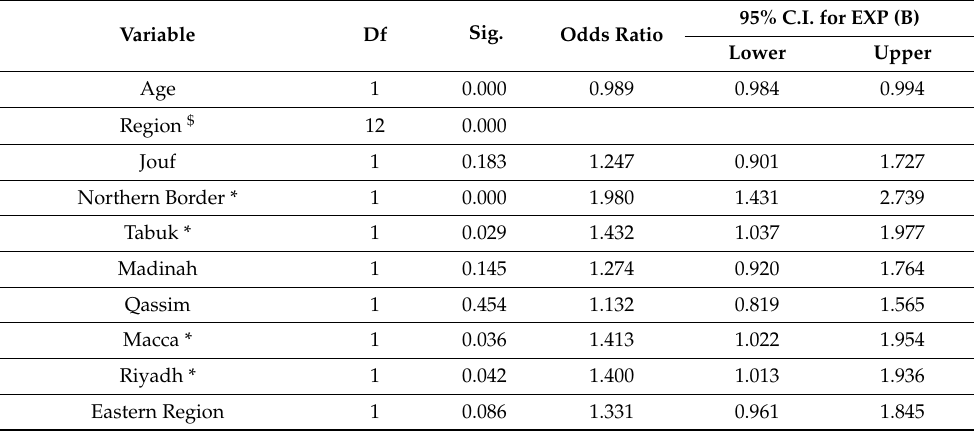
Table 5. Regression model results showing variables related to